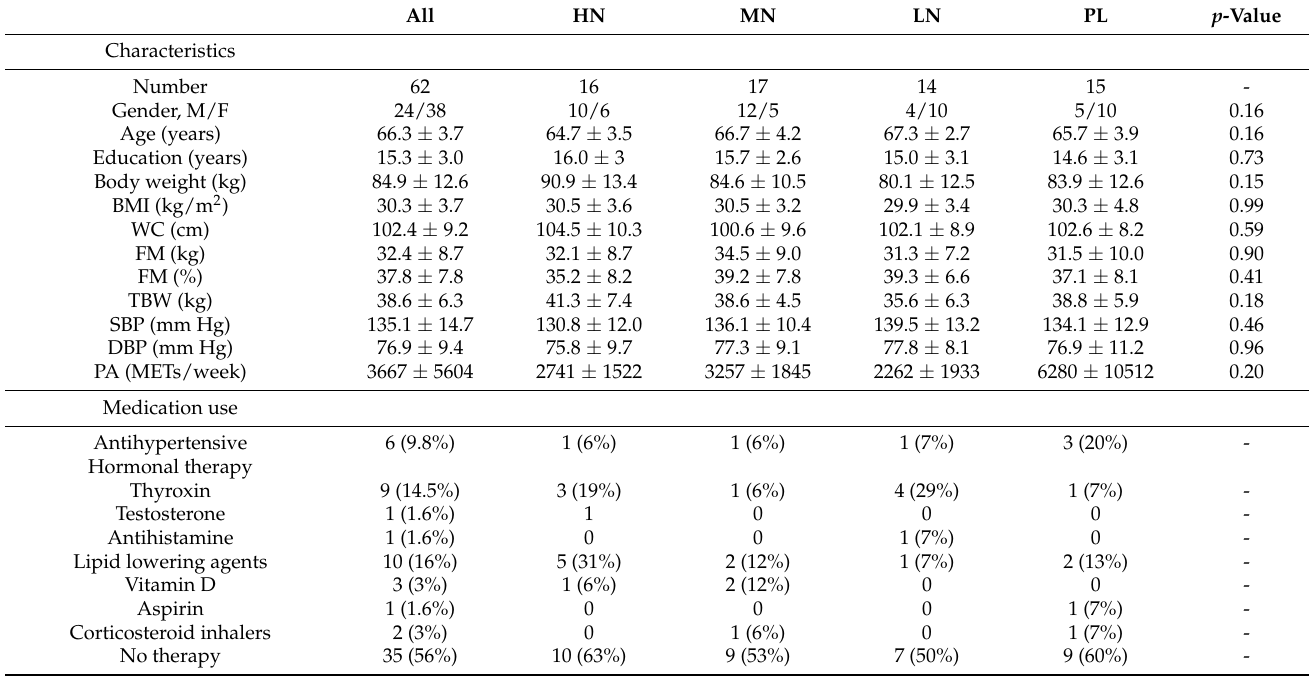
Table 1. Baseline characteristics of the study participants including use of